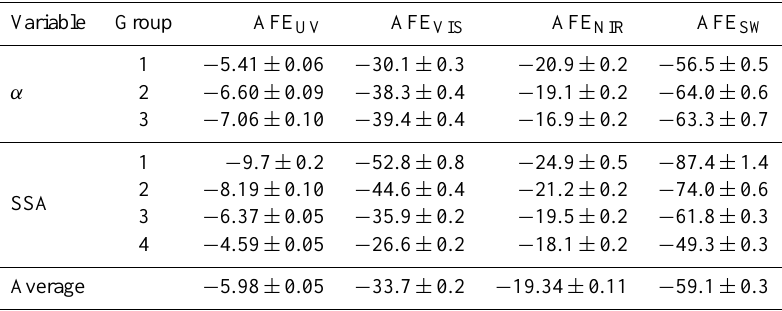
∗ Filters applied are the same as in level 2.0 except for AOD 440 (see text). Table 3. AFE values and their standard error for the UV, VIS, NIR, and SW ranges for, separately, four SSA and three α intervals over the Iberian Peninsula. Units are Wm − 2 τ − 1 . SSA groups: 0.85 ≥ SSA 1 > 0 . 80 (group 1), 0.90 ≥ SSA 2 > 0 . 85 (group 2), 0.95 ≥ SSA 3 > 0 . 90 (group 3), and 1.0 ≥ SSA 4 > 0 . 95 (group 4); and α groups: 0 ≤ α 1 ≤ 1 (group 1), 1.0 ≤ α 2 ≤ 1 . 5 (group 2), and 1.5 < α 3 ≤ 2 (group 3). The average values without any classification are also